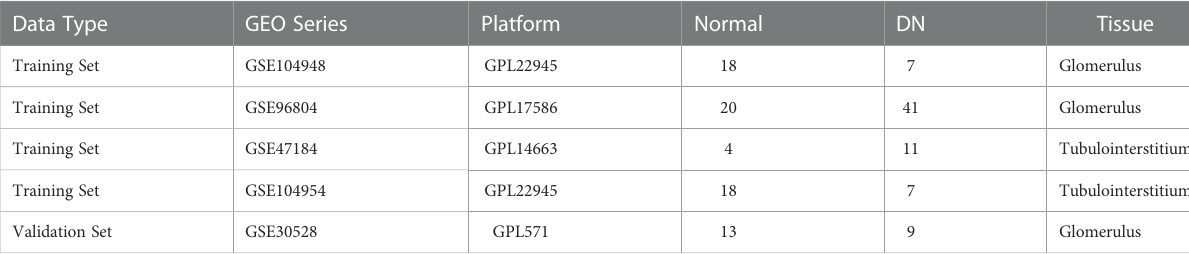
TABLE 1 Detailed information about the collected datasets.